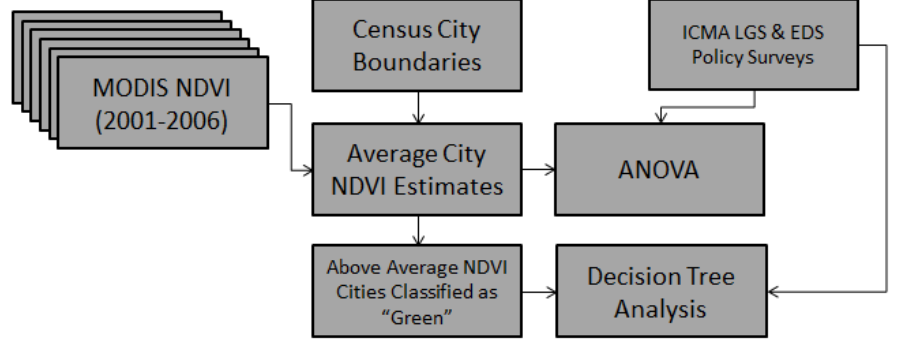
Figure 2. Technical flow chart of steps and data used in this